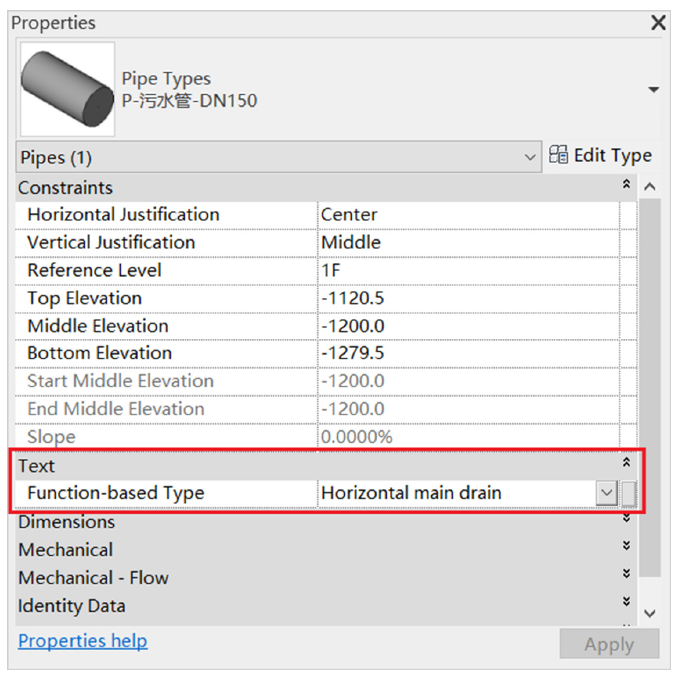
Figure 7. The properties panel for labeling separately.